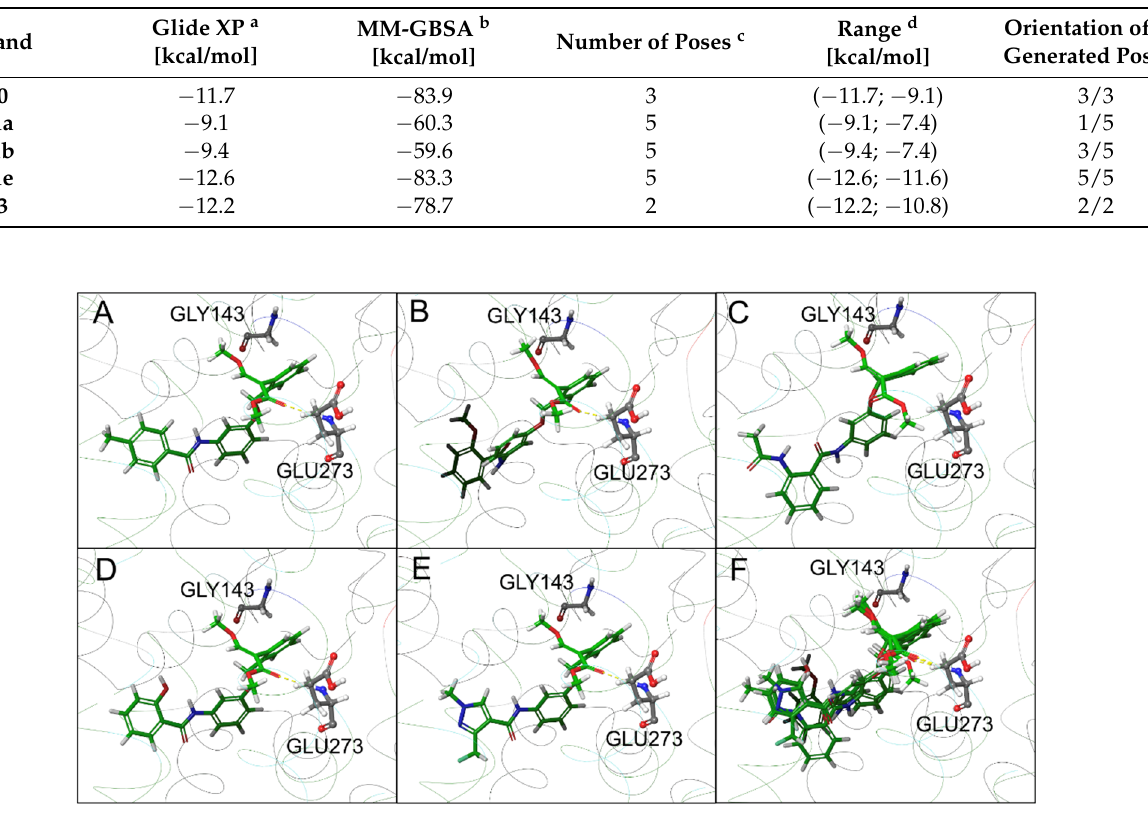
Figure 8. Top-scoring docking poses for compounds ( A ) 10 , ( B ) 11a , ( C ) 11b , ( D ) 11e , and ( E ) 13 . In ( F ), the top-scoring docking poses for all the tested compounds are reported.